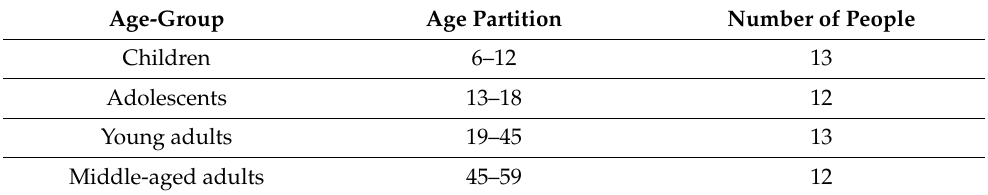
Table 4. Age range and number of participants in the experiment. Age-Group Age